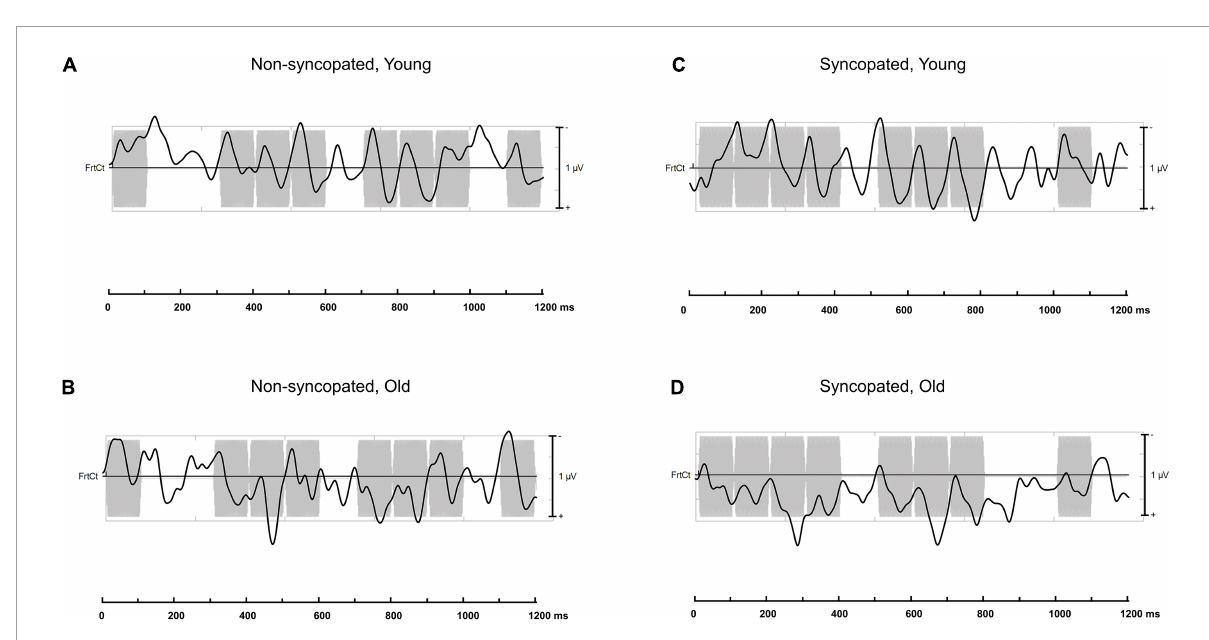
FIGURE6 Electroencephalography (EEG) data presented in the time-frequency domain averaged across each repetition of the rhythm and the montage of fronto-central electrodes used in analysis for younger adults (A,C) and older adults (B,D) for non-syncopated (A,B) and syncopated (C,D) rhythms for fast tempo overlaid onto their respective auditory